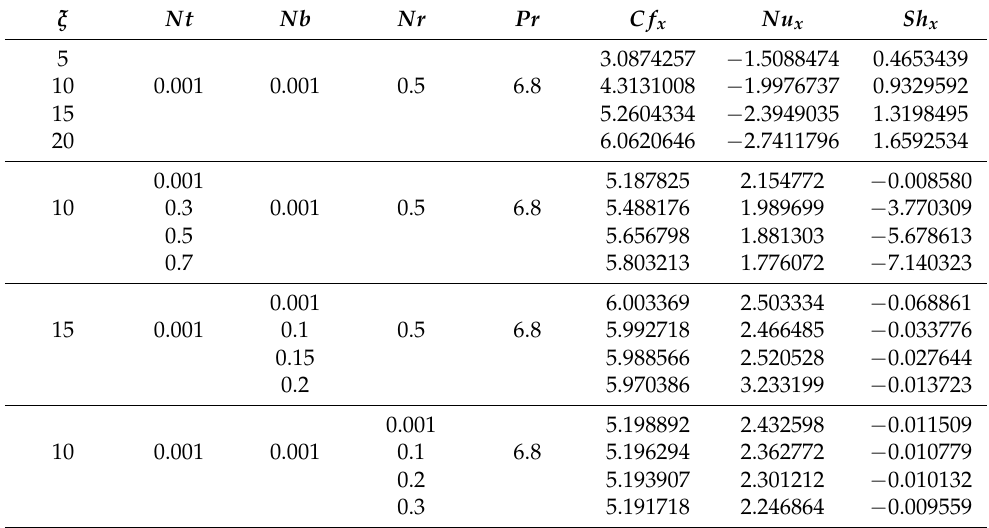
Table 1. Skin friction, and heat and mass transfer coefficients for β 1 = 0.5, Gr T = Gr C = 0.5, λ = − 0.09, Ec = 0.05, Le = 0.4, and R 1 = 0.3.